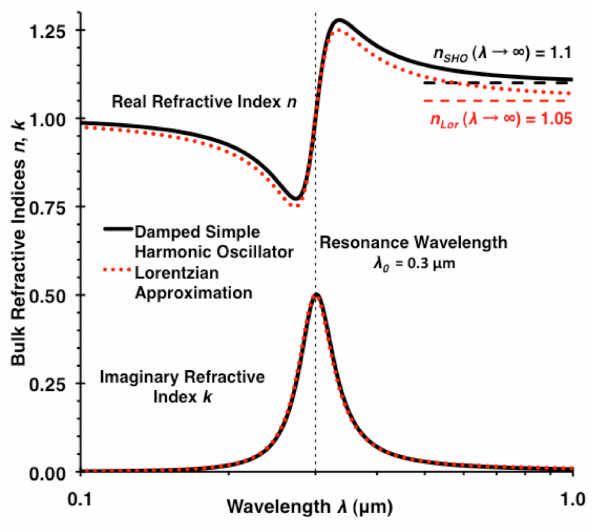
Fig. 3. Bulk absorption ˚Angstr¨om coefficient for the damped sim- ple harmonic oscillator (AAC bulk SHO ; solid black line) and its Lorentzian approximation (AAC bulk Lor ; dotted red line) shown as a function of wavelength λ (logarithmic scale) with the resonance wavelength λ 0 = 0 . 3µm shown as the vertical dashed line and the long wavelength limits of AAC bulk as horizontal dashed